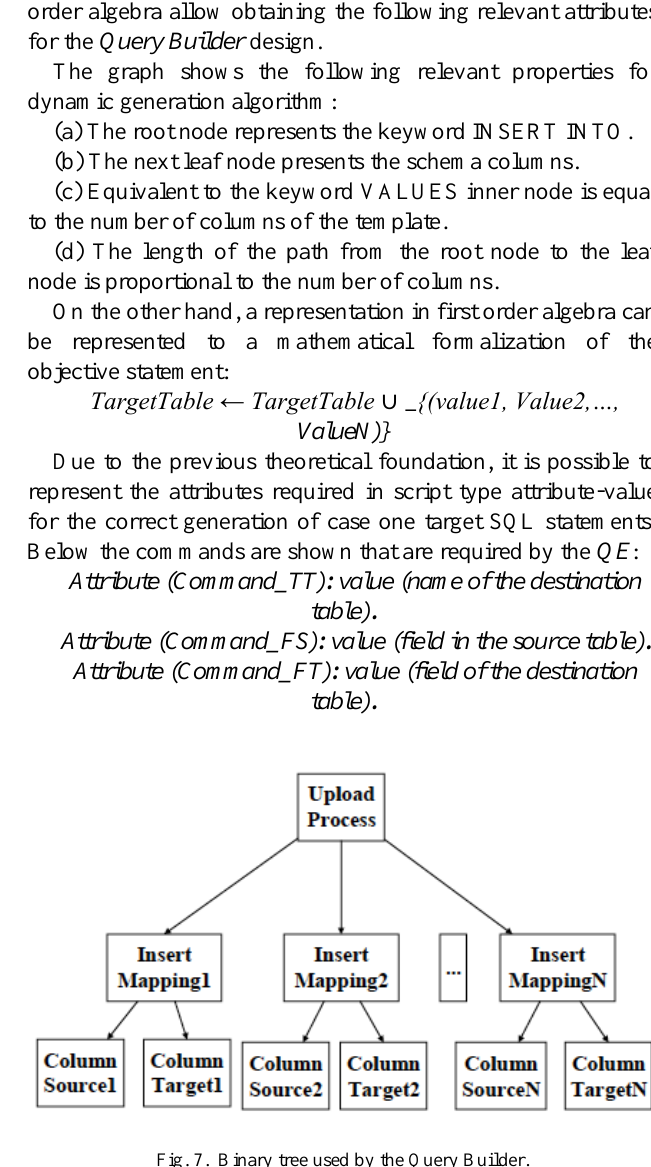
Fig. 7. Binary tree used by the Query